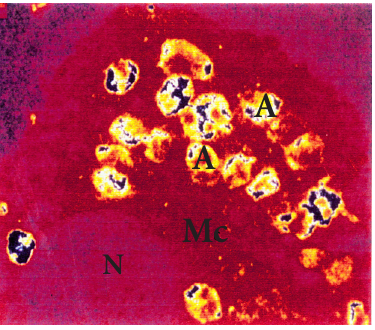
Figure 3: Confocal analysis of mouse T. cruzi -infected macrophages (Mc) reacted with rabbit anti-Tc52 immune serum. Fluorescent in- tensity was converted into colors by the computer. Positive signals (large blue spots) are evidenced in association with T. cruzi intracel- lular amastigotes (A). (N), Macrophage